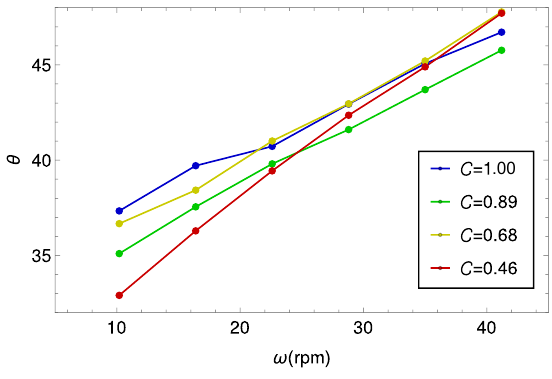
Figure 4. Dynamic angle of repose of the granular flow surface versus the rotation speed of the drum for di ff erent grain shapes described in Table